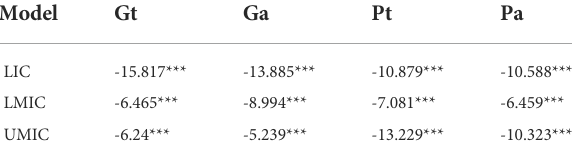
TABLE 5 Cointegration with an error correction